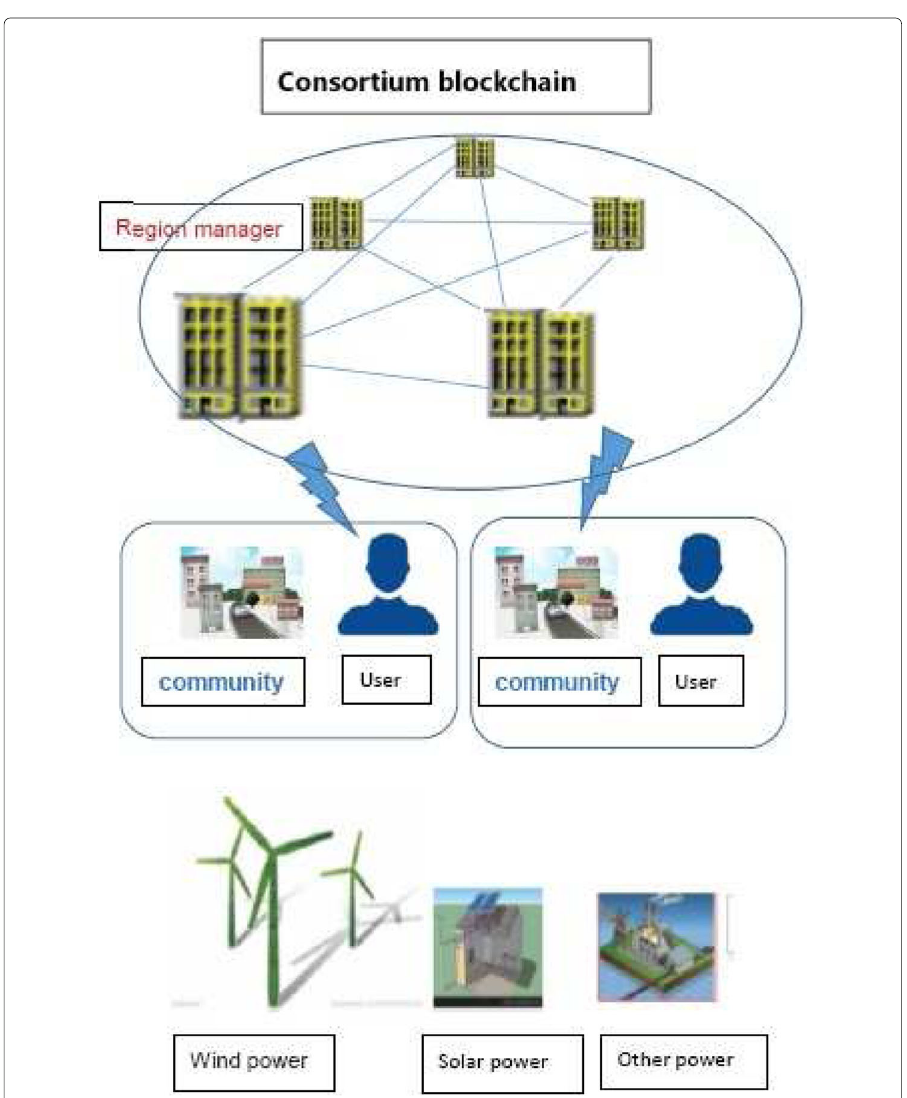
Fig.2 The system structure. The system of our scheme consists regional manager, the communities and